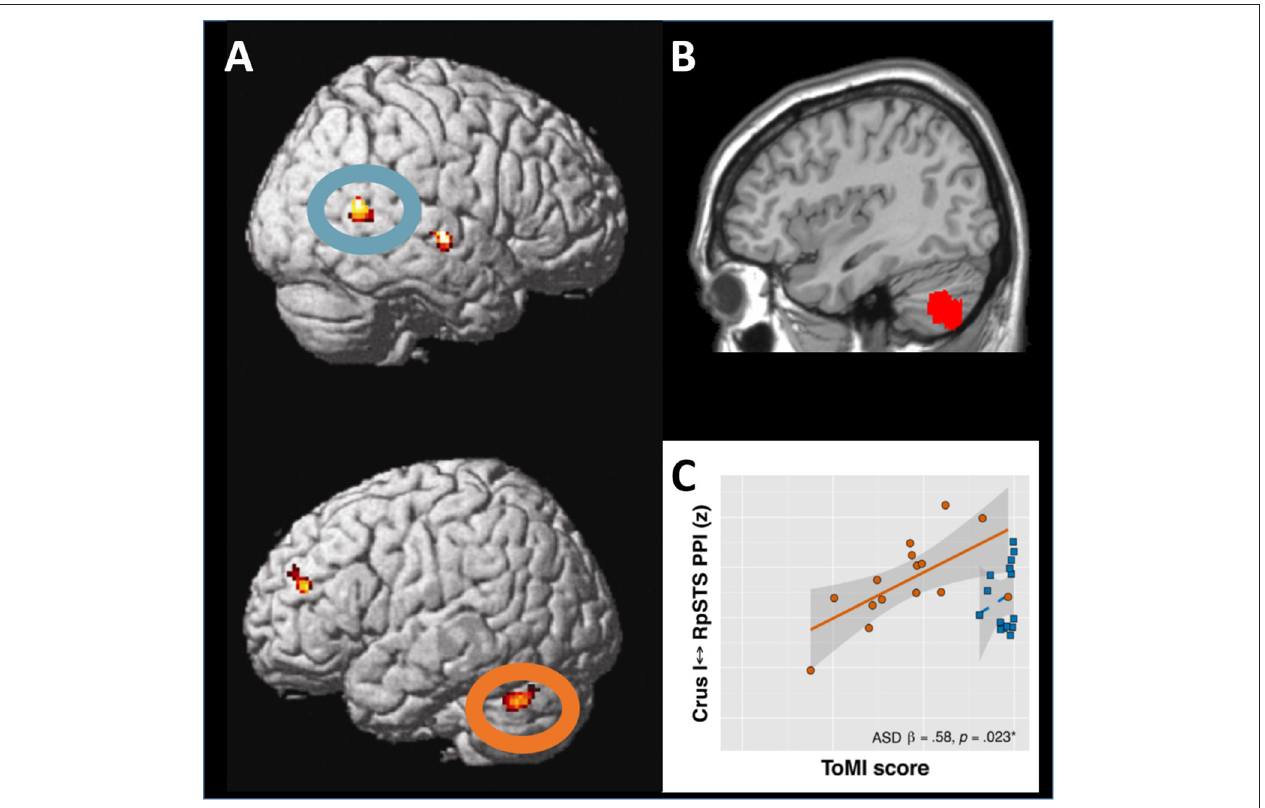
FIGURE 1 | Interaction between the lateral posterior cerebellum and the superior temporal sulcus in social cognition. (A) During visual perception of body motion, the right superior temporal sulcus (upper panel, blue oval) and the left lateral cerebellar lobule Crus I (lower panel, orange oval) show functional and effective connectivity. Adapted from Sokolov et al. (2012), with permission from Elsevier. (B) When corresponding regions in the left lateral posterior cerebellar cortex are affected by tumors, patients exhibit significant deficits in perception of body motion. Adapted from Sokolov et al. (2010), with permission from Oxford University Press. (C) In adolescents with autism spectrum disorders, theory of mind capacities correlate with the strength of effective connectivity between the cerebellar lobule Crus I and the superior temporal sulcus. Adapted from Jack and Morris (2014), with permission from